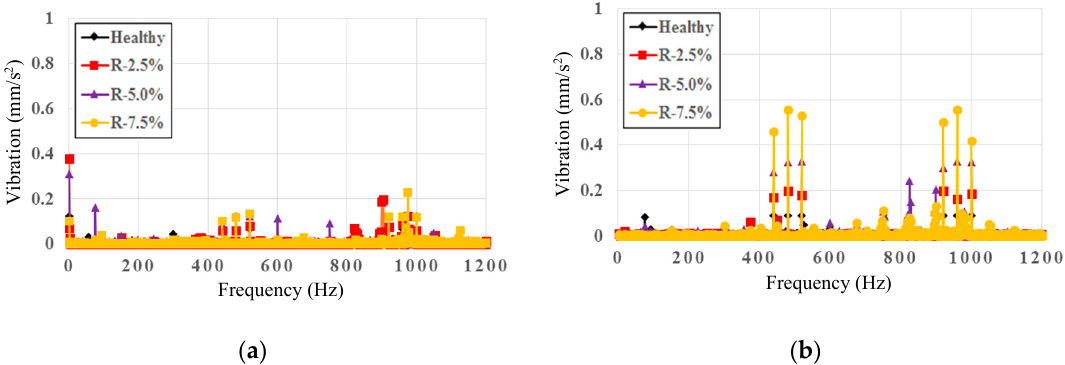
Figure 7. FFT analysis of vibration waveforms emitted from the motor with radial demagnetization: ( a ) no load torque; ( b ) 70% load torque.